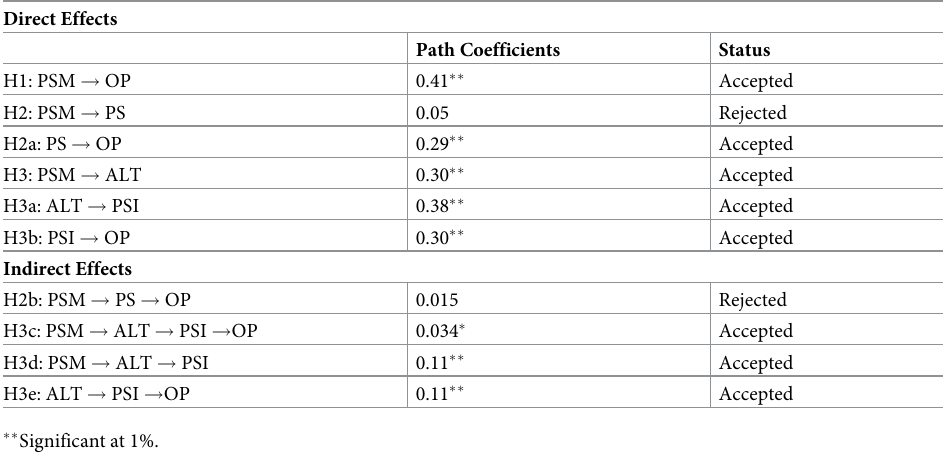
Table 5. Direct and indirect